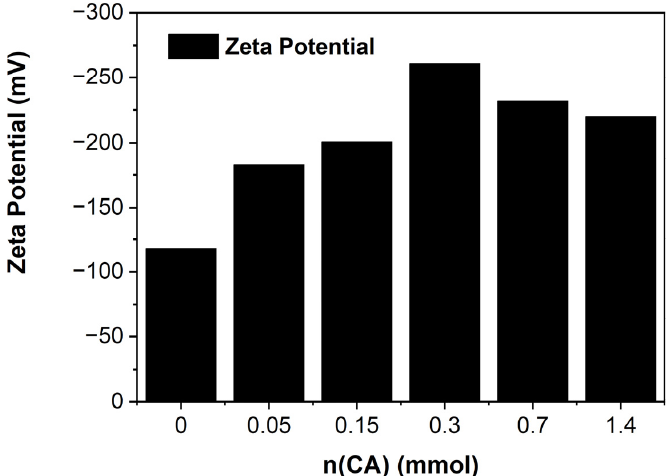
Figure 9. Zeta potential at pH = 7.0 for all CNF membranes.